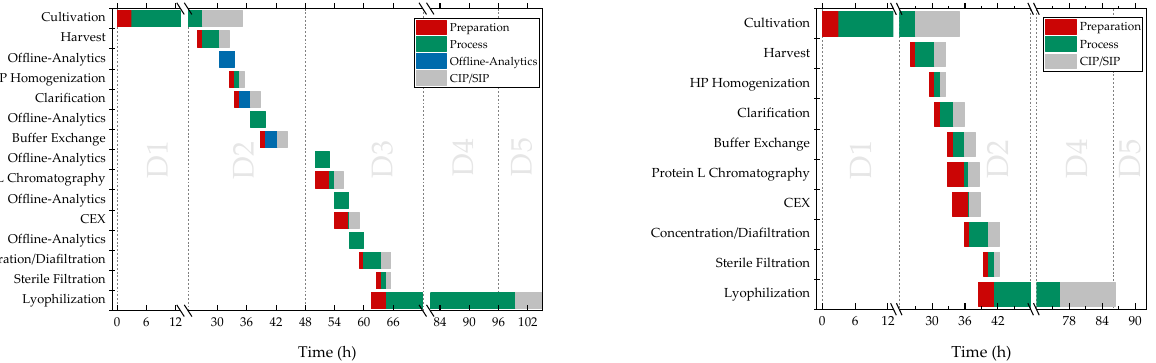
Figure 13. ( a ) Conventional process schedule based on offline analytics vs. ( b ) optimized process schedule enabled by PAT for APC and